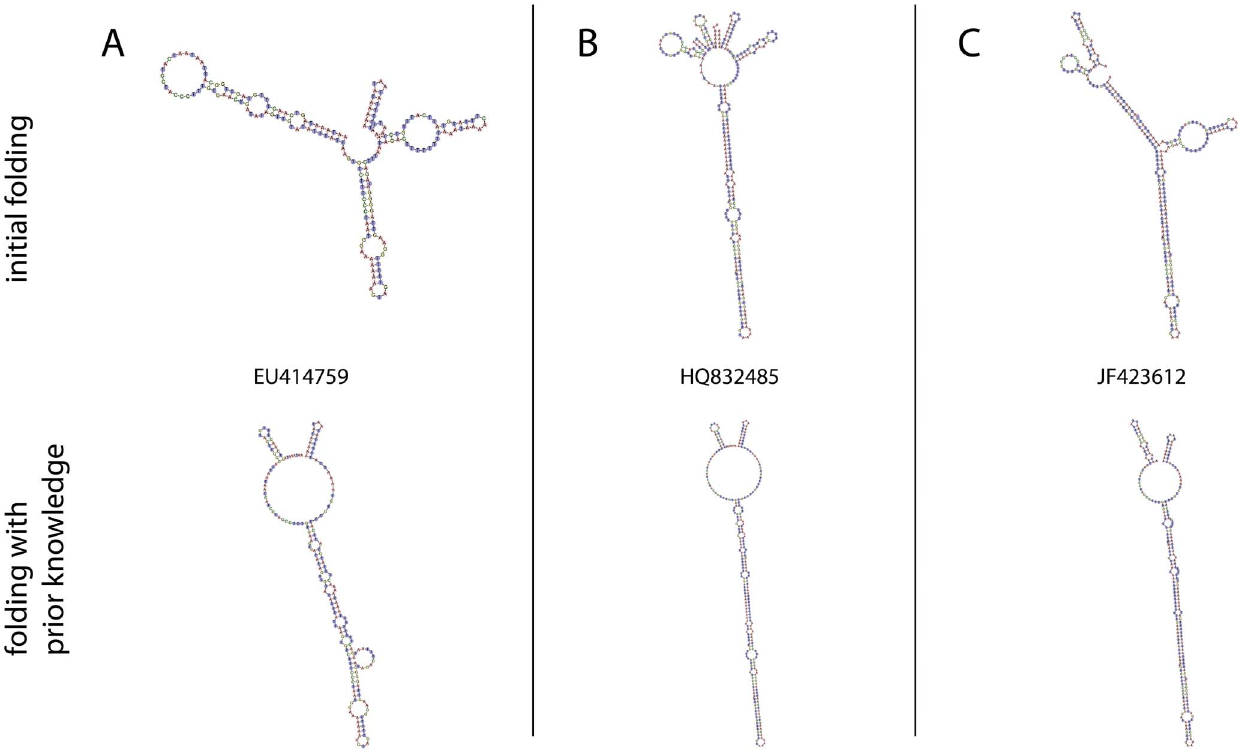
Figure 2. Secondary structures of the ITS1 region from three different sequence types. ITS1 secondary structures from ( A ) EU414759, ( B ) HQ832485 and ( C ) JF423612. The illustrated structures did not fold into the typical three helix conformation when folded initially with UNAFold (upper images). By breaking the sequences into three parts based on the known location of sequence motifs, each part could be folded individually. The concatenated helices (bottom images) result in the typical three-helix common core structure predicted by the direct folding of the majority of all annotated sequences.